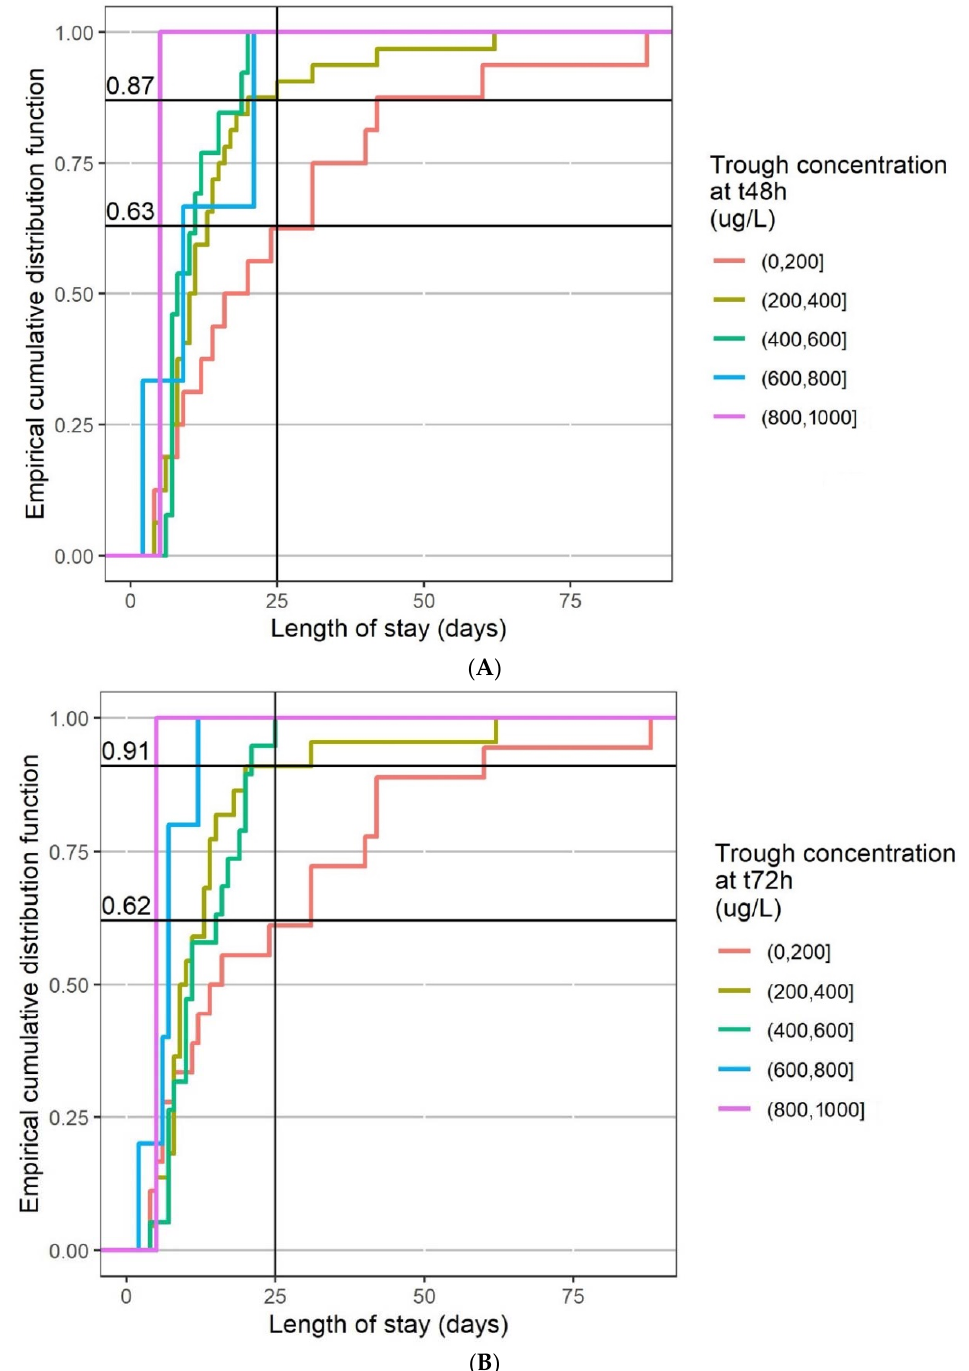
Figure 7. Empirical cumulative distribution function of length of stay by range of HCQ blood trough concentrations at t48 h ( A ) and t72 h ( B